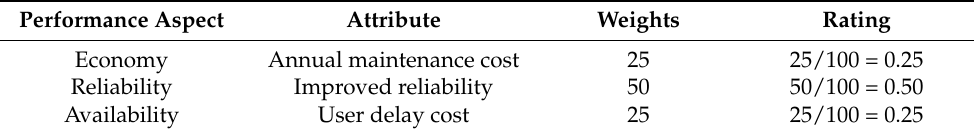
Table 3. Weighting of